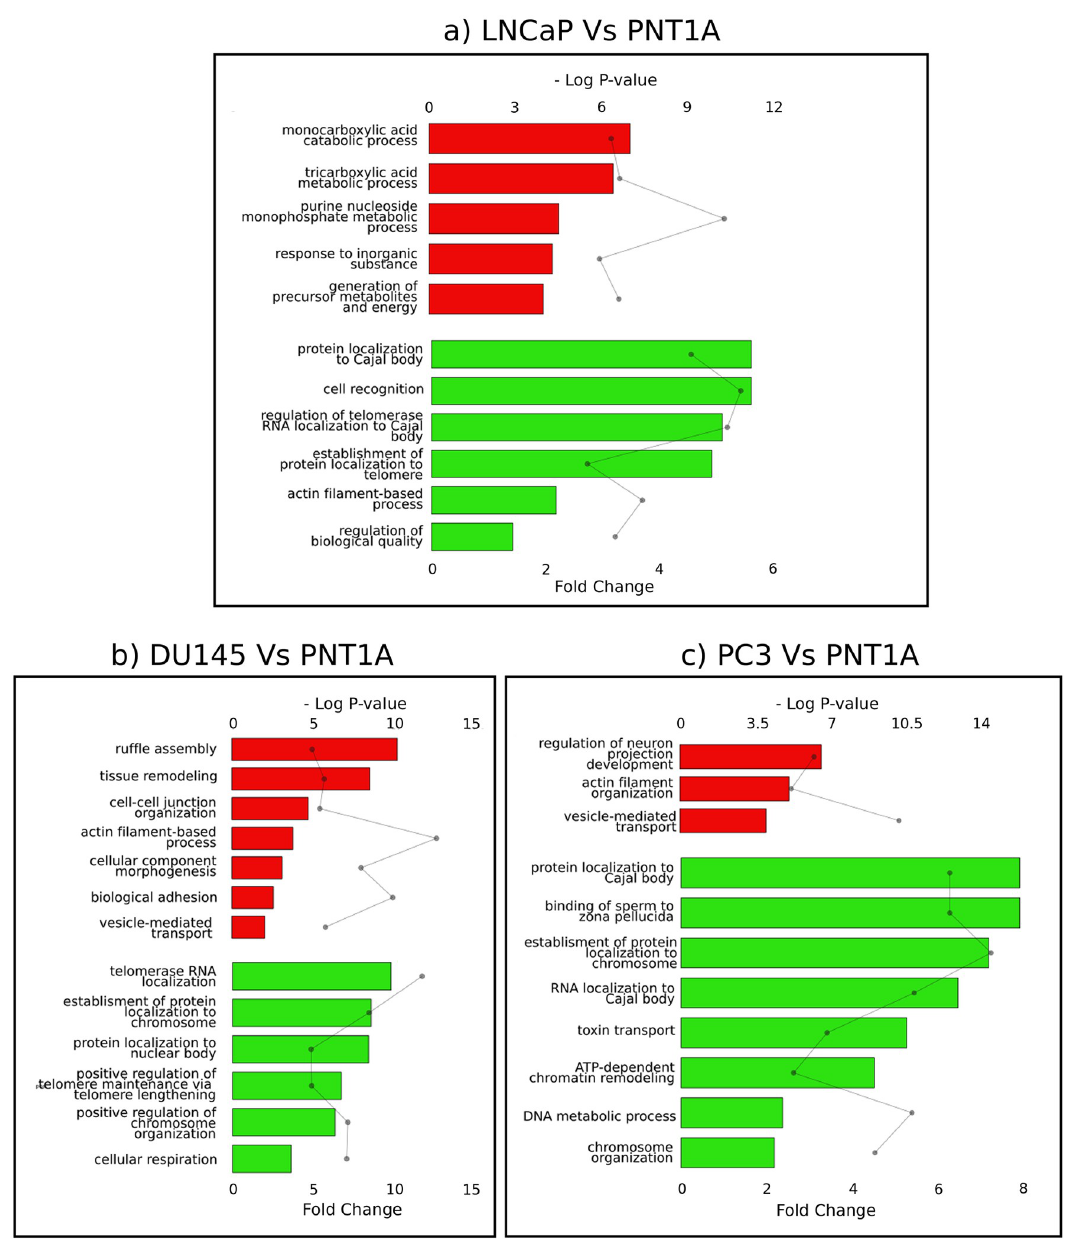
Fig 2. Functional enrichments of proteins up- and downregulated in PC cell lines. Bar graphs represent relative fold change of Gene Ontology Biological Processes among (A) LNCaP, (B) DU145, (C) PC3 upregulated proteins (red bars) and downregulated proteins (green bars), as compared to PNT1A cells. Significance is represented in the dot plot by –log (P-values).